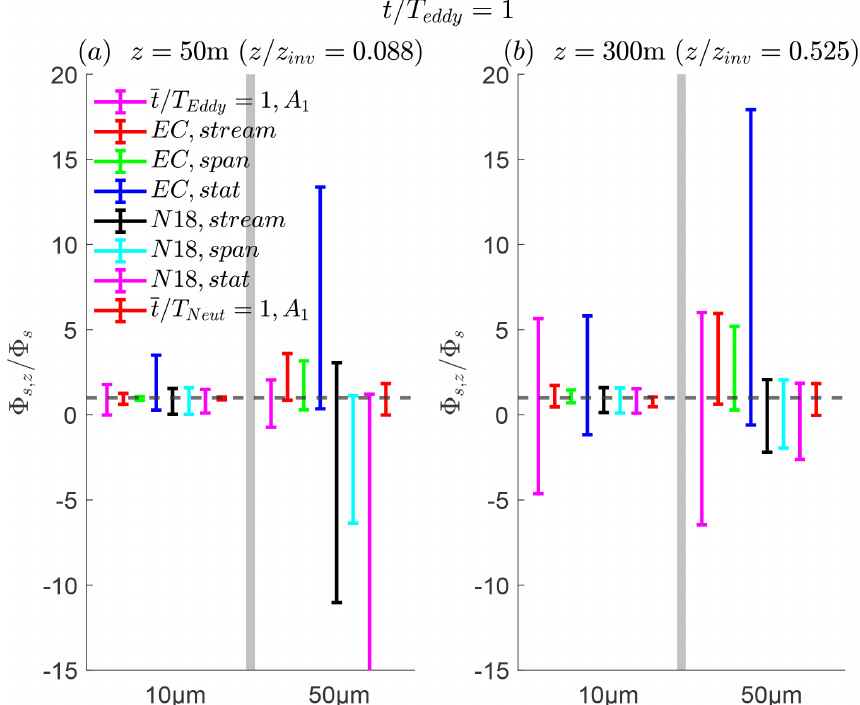
Figure 14. Summary of the various methods for inferring effective surface fluxes from (a) z/z inv = 0 . 088 and (b) z/z inv = 0 . 525. The left side of the abscissa in each plot is for 10µm diameter aerosol particles, and the right side represents 50µm sizes. The first legend entry corresponds to the subregion sampling analysis in Sect. 3.2. The second set of legend entries is eddy covariance (EC) and streamwise (as stream), spanwise (as span), and stationary (as stat), corresponding to the simulated instrumentation. The next set of legends corresponds to the Nissanka et al. (2018) model as N18, in which the elevated concentration is constrained by the simulated instrumentation. The last legend item is the surface flux variation from a neutral stability condition for t/T neut = 1. Aside from the last legends, the data are based on an averaging time of 1 T eddy . The dashed reference line represents (cid:56) s,z /(cid:56) s = 1, meaning that the inferred surface flux matches the LES surface